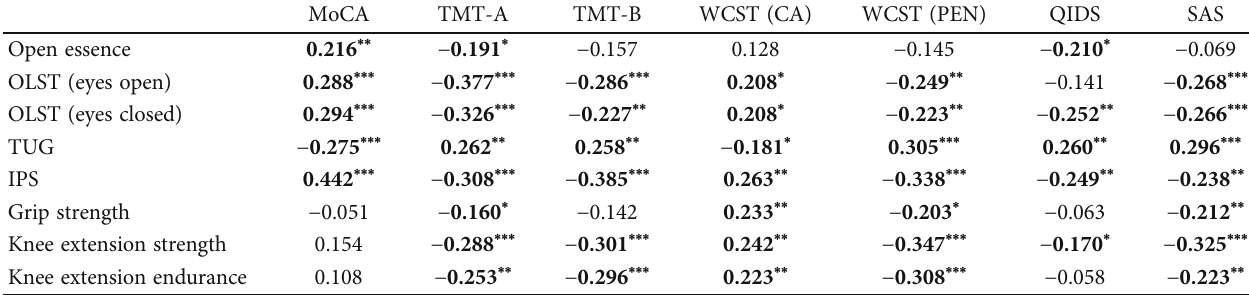
Table 3: Correlation between cognitive function tests and olfactory identi fi cation test, balance capability tests, and muscle strength tests in the entire